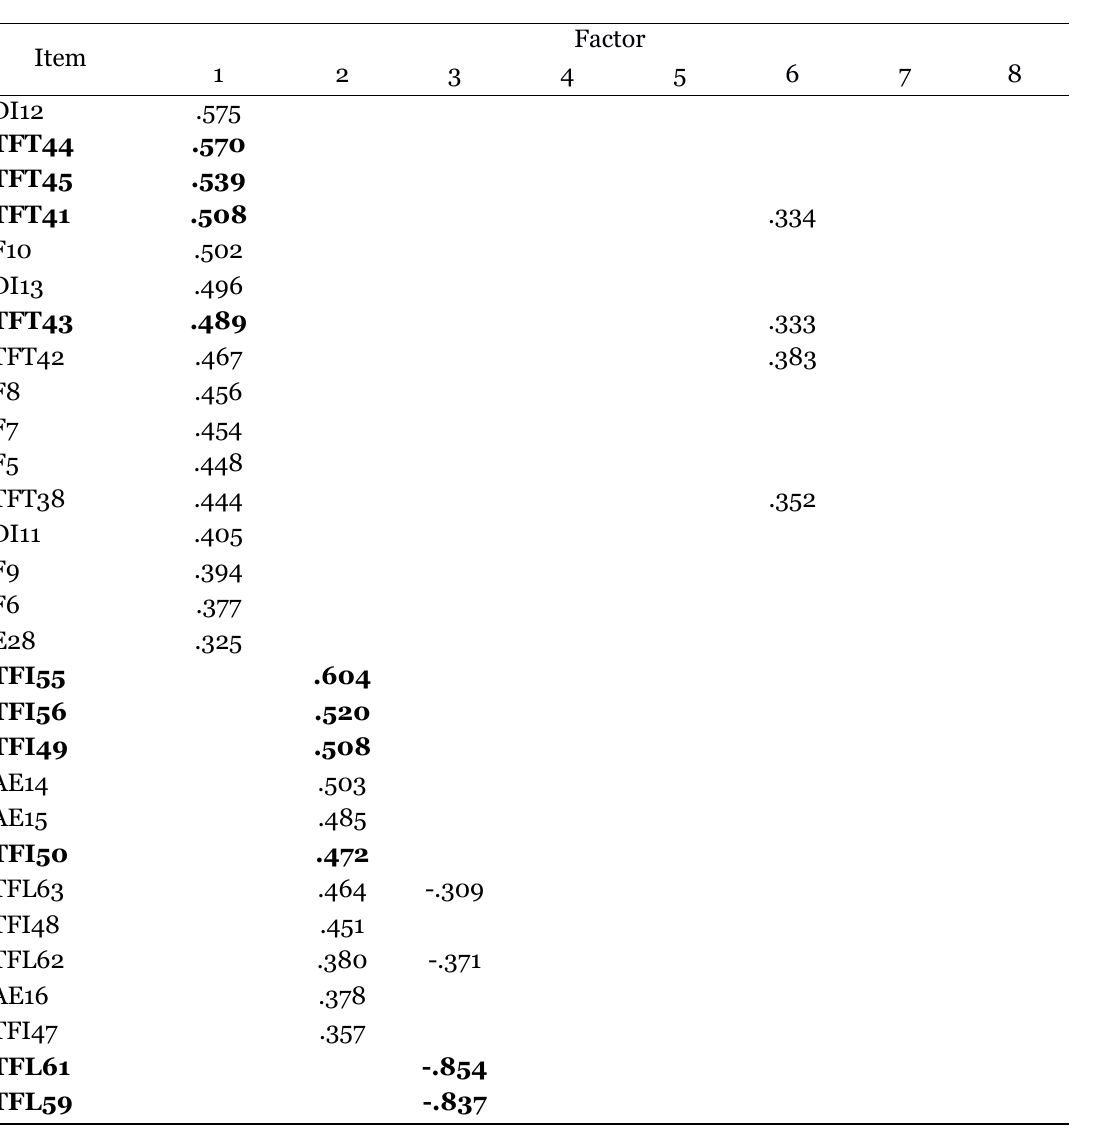
Exploratory Factor Analysis of 66 Prospective Items for the Extended CoI